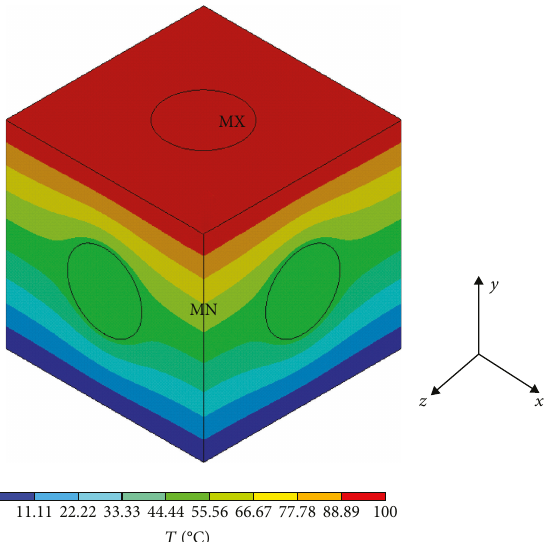
Figure 21: Temperature distribution of the crosslinked model.